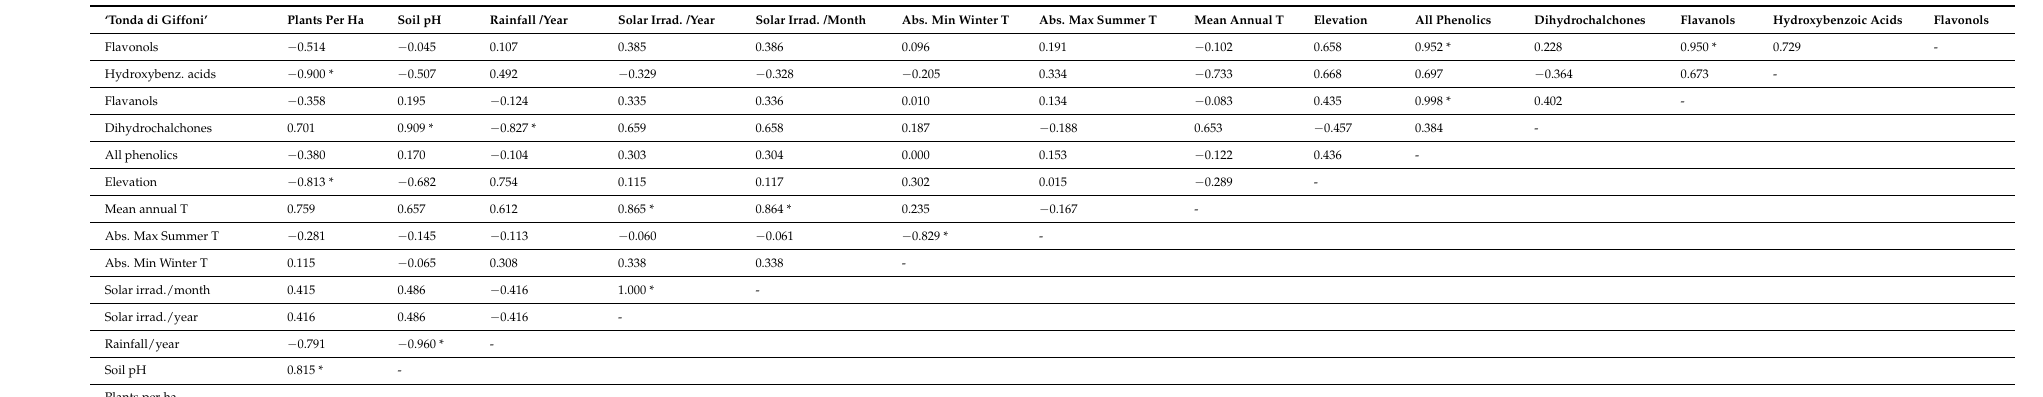
Table 3. Correlation table of the variables for the cultivar ‘Tonda di Giffoni’.